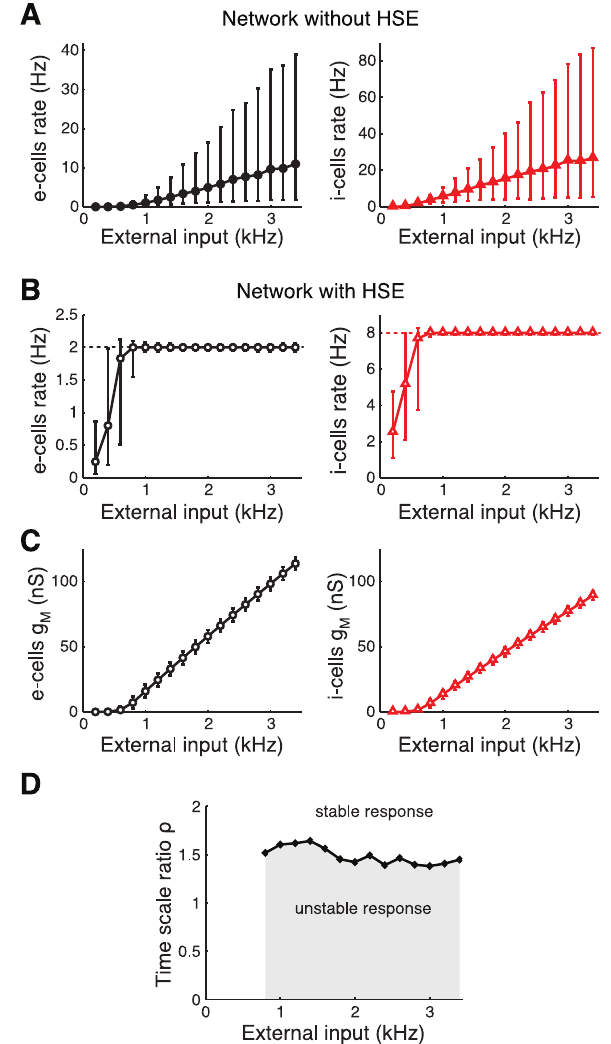
Figure 5. Adapting to persistent changes in external drive to the recurrent network. Response of a non-adapting network and a network with HSE to a range of external excitatory input levels to both e-cells and i-cells. Since the number of external inputs and their frequency are interchangeable in our model, the external excitatory drive is expressed in the compound rate (in kHz). A: Median firing rate of e-cells (left) and i-cells (right) in a network without HSE. Error bars give 5%–95% percentiles. B: As in panel A for network with HSE. Dotted lines at 2 Hz (left) and 8 Hz (right) give target rates of e-cells and i-cells. C: Population mean g M of the e-cells (left) and i-cells (right) in the network with HSE. Error bars give standard deviation. D: Required ratio of adaptation time scales r for stable adaptation dynamics when the network is perturbed from its adapted state characterized in panels B and C. The perturbation consists of a 0.3 kHz step increase of the external drive to all cells. The same criterium for stability of the adaptation dynamics is used as in figure 2.